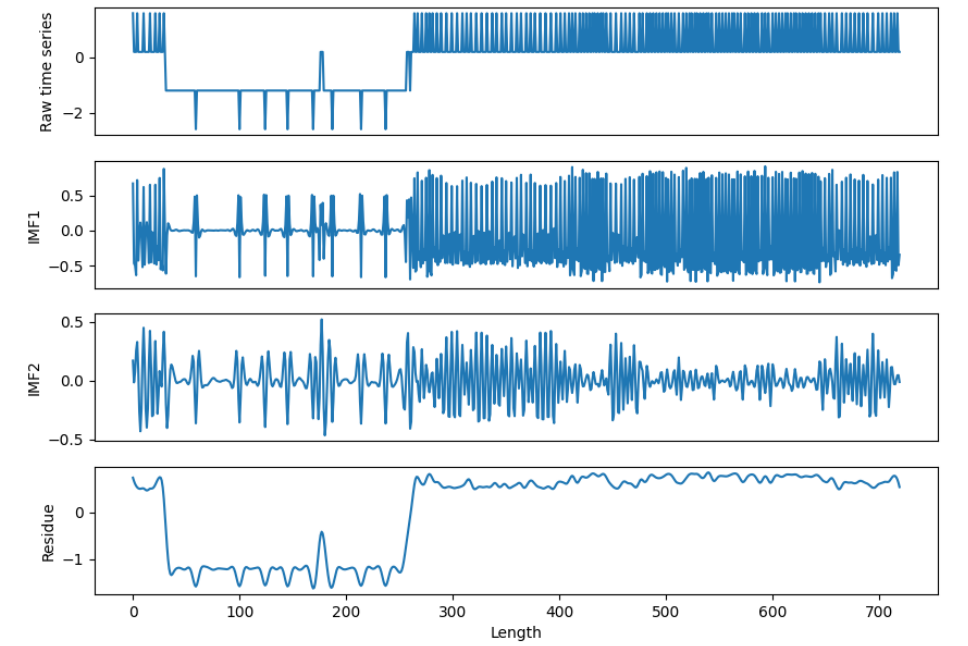
Figure 2. A raw time series and its corresponding sub-series decomposed by CEEMD in the Screen- Type